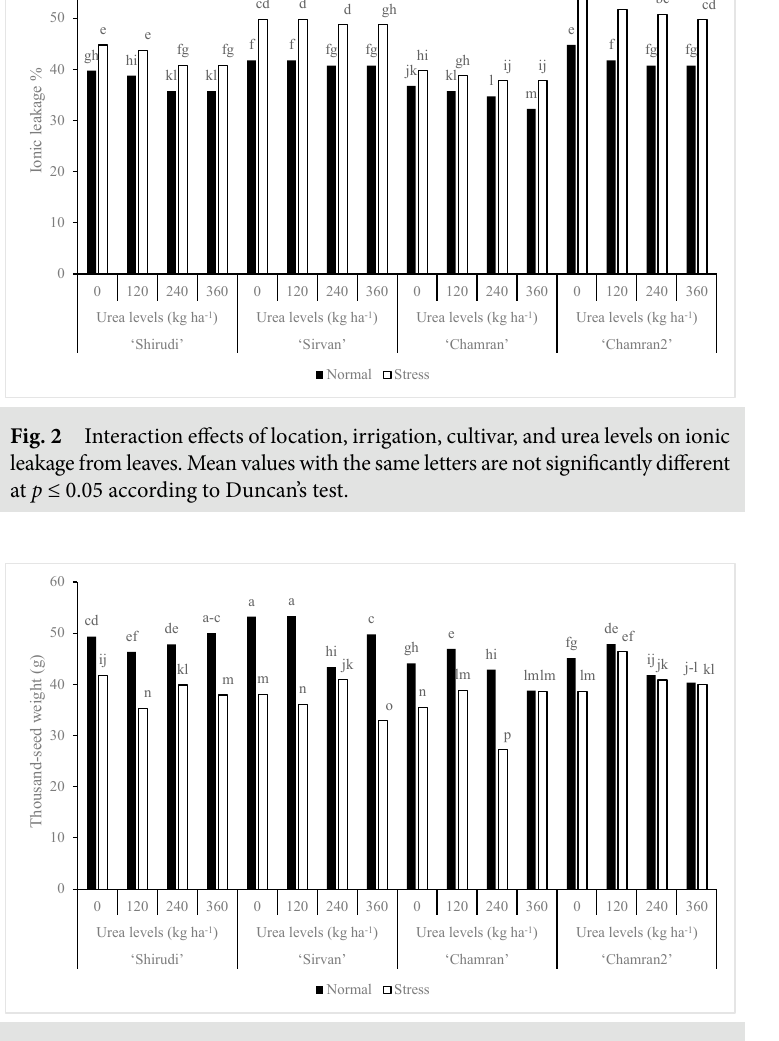
Fig. 3 Interaction effects of location, irrigation, cultivar and urea levels on 1,000- seed weight. Mean values with the same letters are not significantly different at p ≤ 0.05 according to Duncan’s